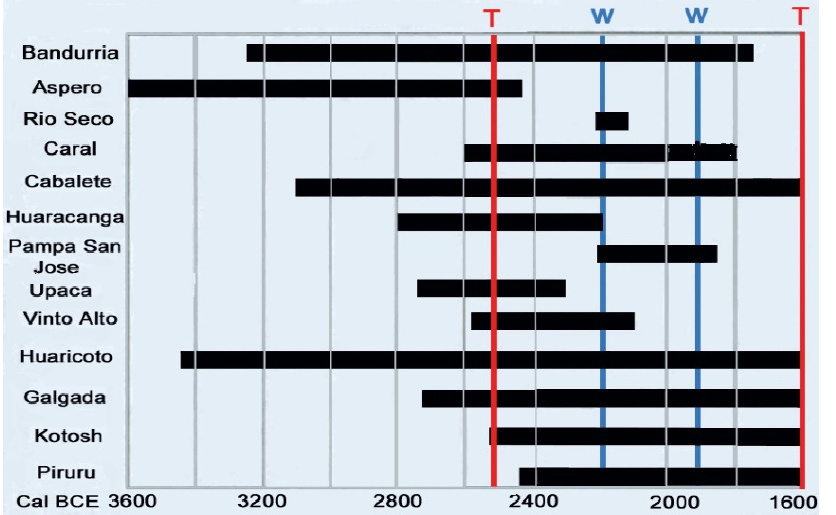
Figure 2. Time duration of the major preceramic sites in the Supe Valley shown in Figure 4 and Appendix A.